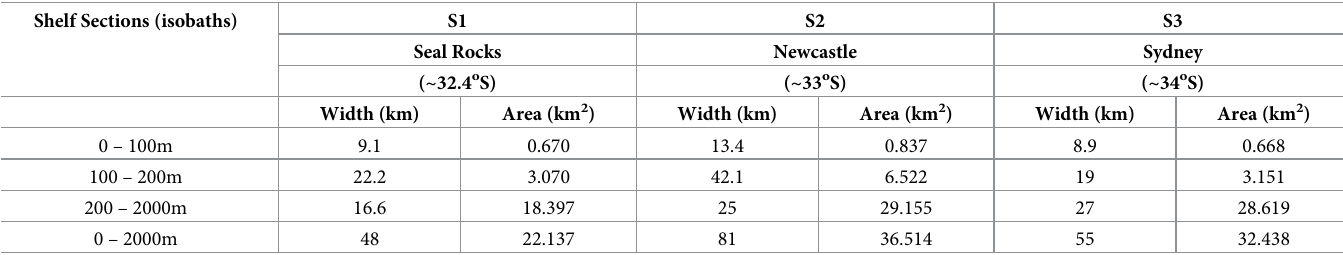
Table 1. Width (km) and area (km 2 ) of the shelf segments at three sections off Seal Rocks (S1), Newcastle (S2) and Sydney (S3). Shelf Sections